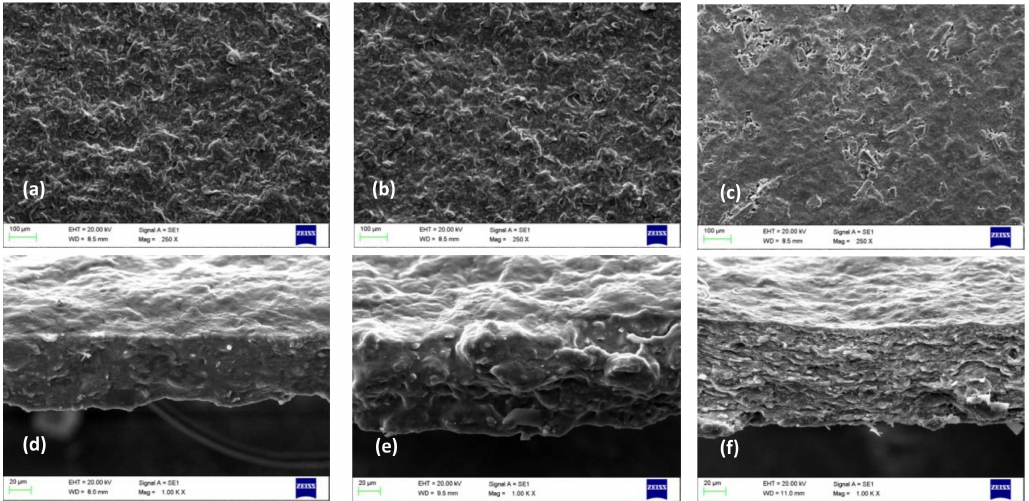
Figure 2. Bio-based films prepared from non-washed apple pomace, without ( a and d ) and with the use of glycerol ( b and e ), show a fluffy and more interconnected structure compared to bio-based films prepared from washed apple pomace with the use of glycerol ( c and f ). Images of ( a ), ( b ), and ( c ) are taken of the surfaces of films; while ( d ), ( e ), and ( f ) are cross-sectional images. Micrographs were taken respectively at 250 × and 1.00 K × magnifications using a 20.00 kV accelerating